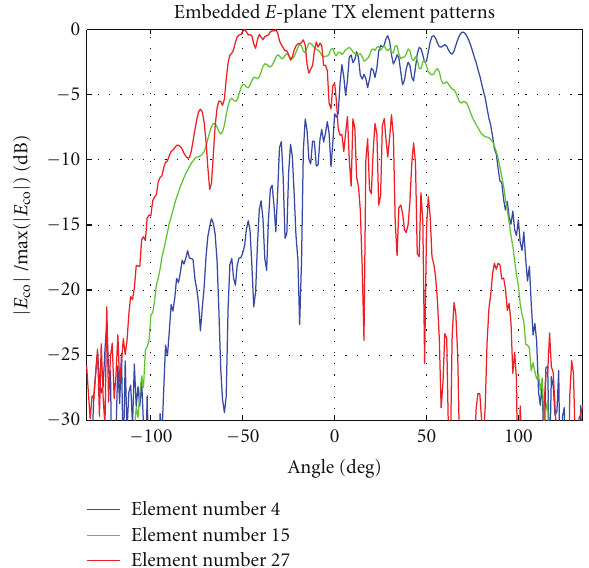
Figure 4: Mutually normalized embedded element patterns mea- sured in TX operation of one of the centre elements (#15) and two of the side elements (#4 and #27) of the array aperture at the centre frequency ( f = 9 . 45GHz) for the copolarisation.